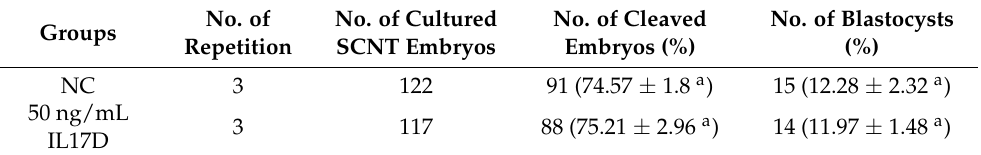
Table 5. Developmental efficiency of SCNT embryos treated with IL17D at 4-cell stage for 48 h. No. of No. of Cultured No. of Cleaved No. of Groups Repetition SCNT Embryos Embryos (%)